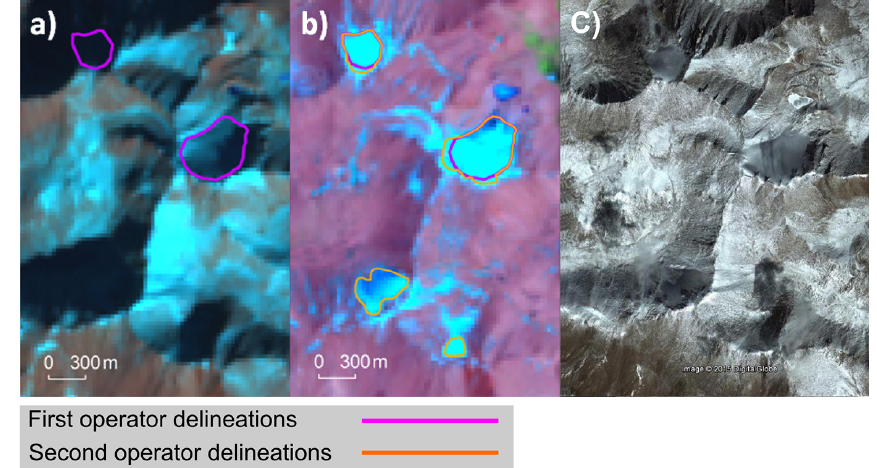
Figure 11. Example of glacier-outline retrieval by a second operator using Landsat imagery path 133 row 035 (35.70 ◦ N, 99.38 ◦ E). Back- ground images are false-colour (bands 7, 4, and 2 as RGB) composites taken on (a) 7 January 2003 and (b) 12 July 2001, in addition to Google Earth TM imagery (c)